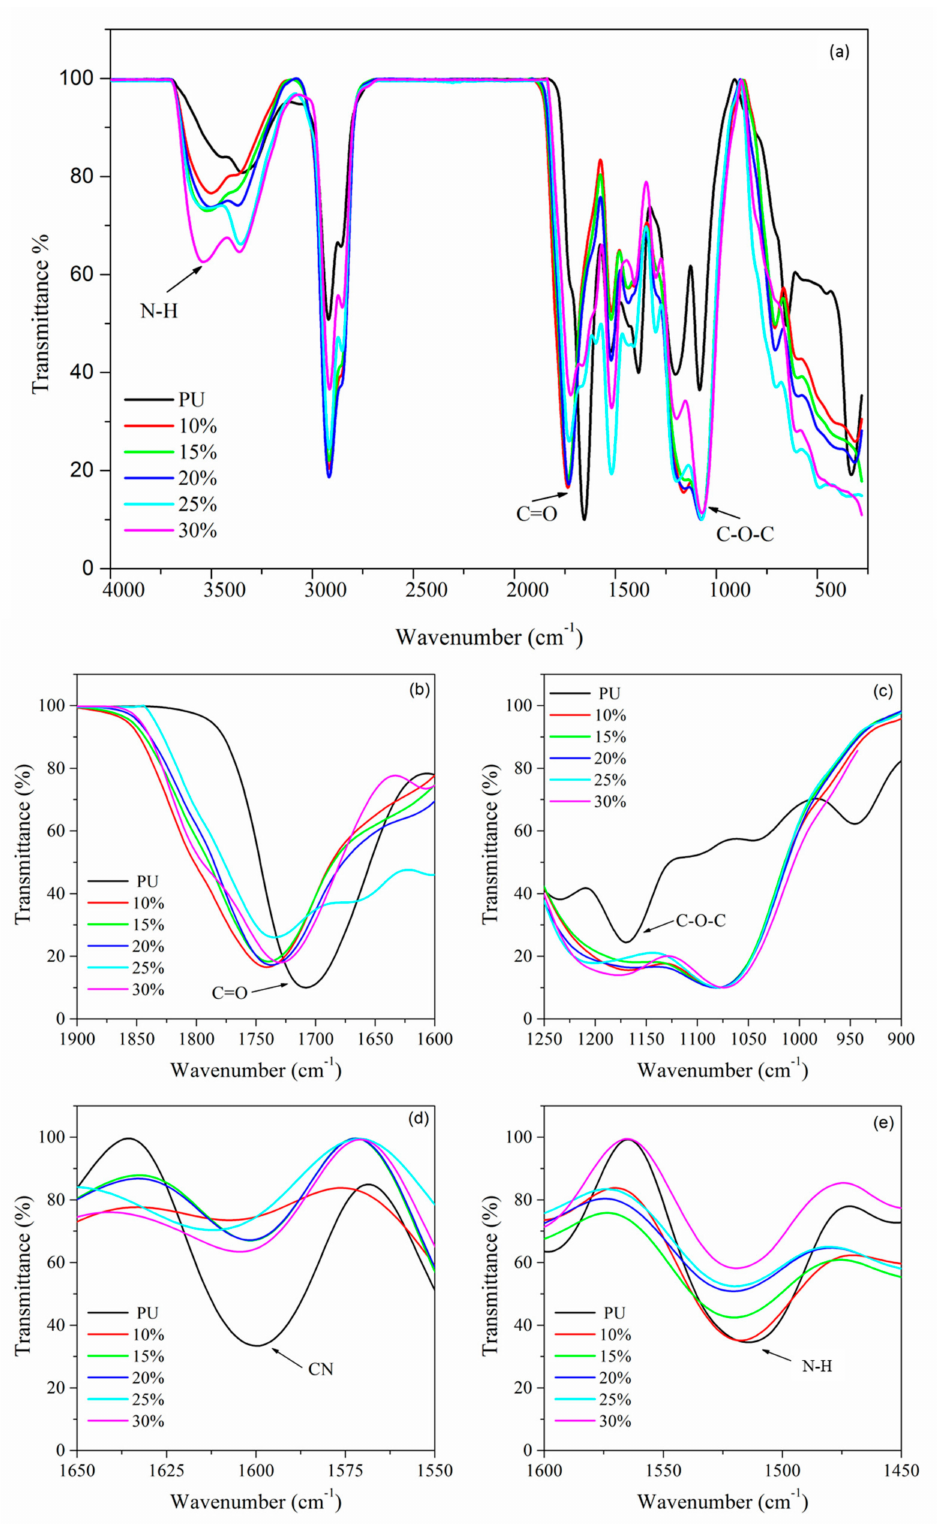
Figure 10. FTIR spectra of PU, PU electrolytes with 10 wt.% to 30 wt.% LiClO 4 at ( a ) full view, ( b ) C=O, ( c ) C-O-C, ( d ) CN and ( e ) N-H